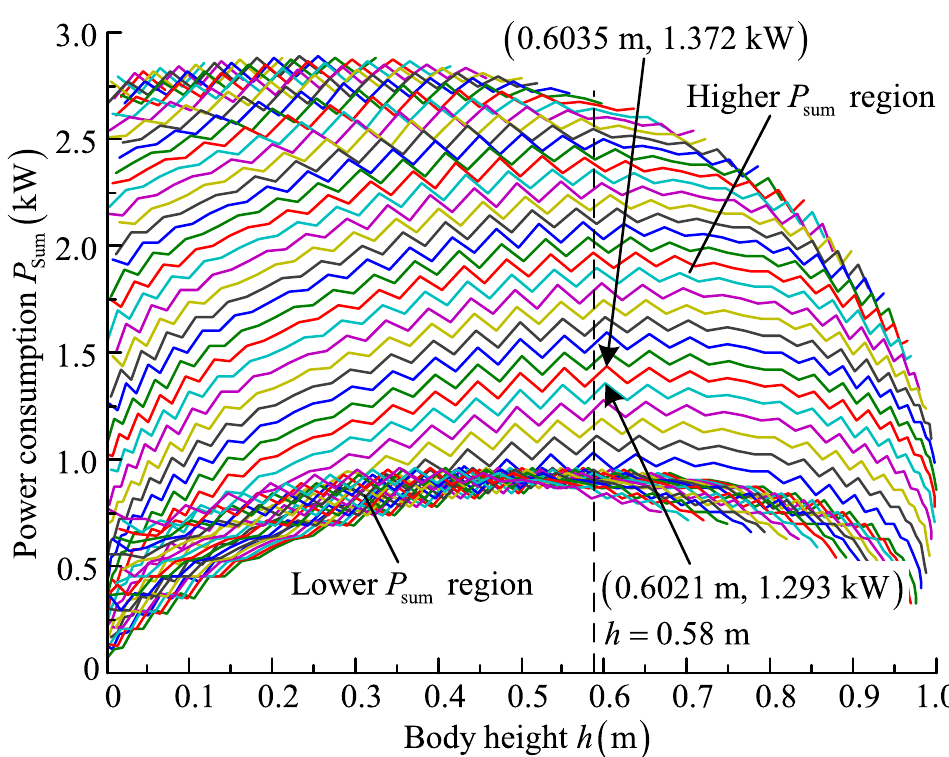
Figure 17 Variable tendency chart of P sum with change in body height